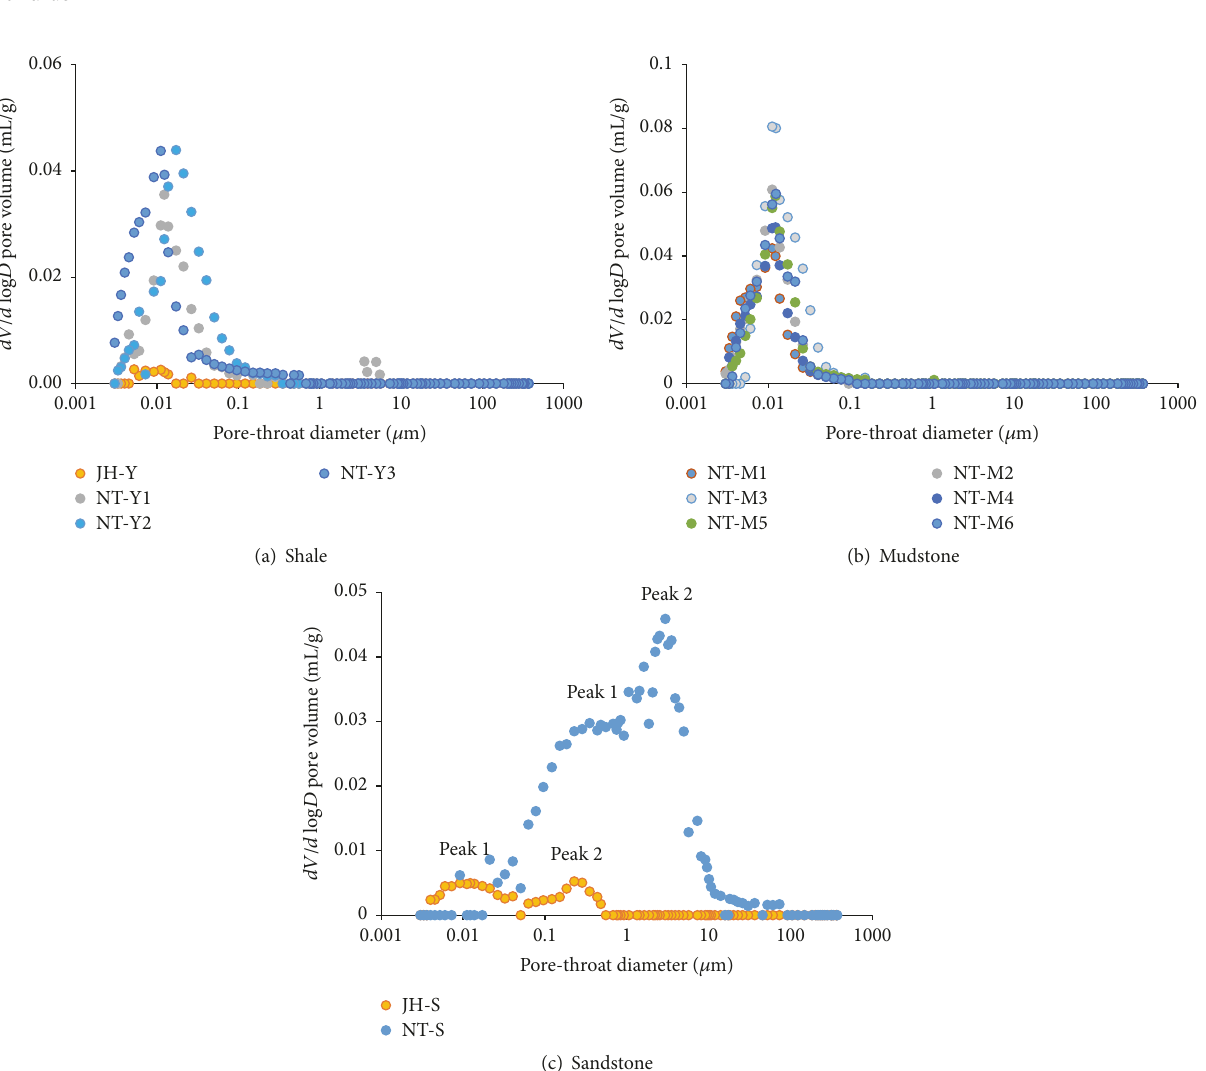
pore of NT-S are remarkably narrower than that of the full spectrum